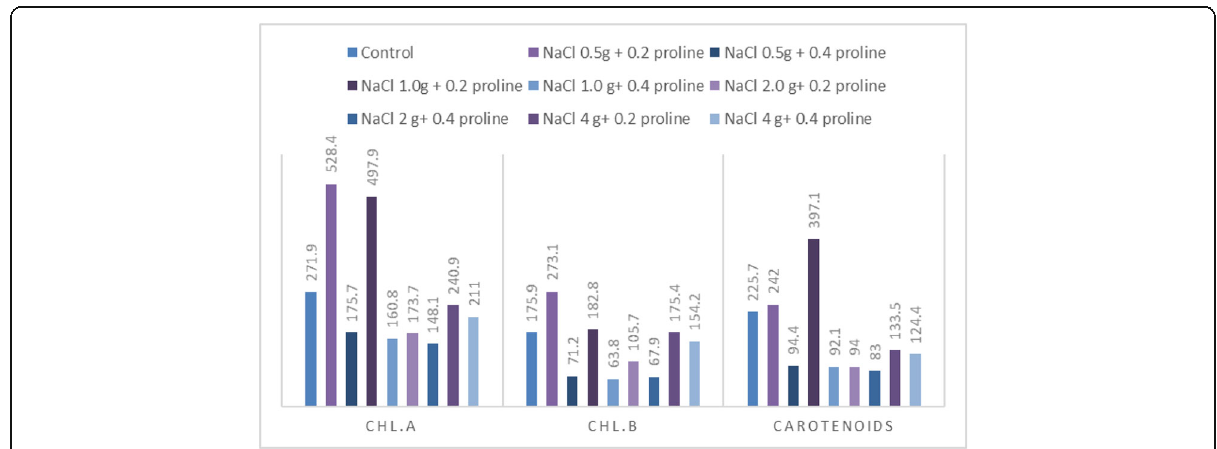
Fig. 3 Photosynthetic pigments contents (mg/100g F.W) in Paulownia tementosa shootlets under different salinity levels and proline